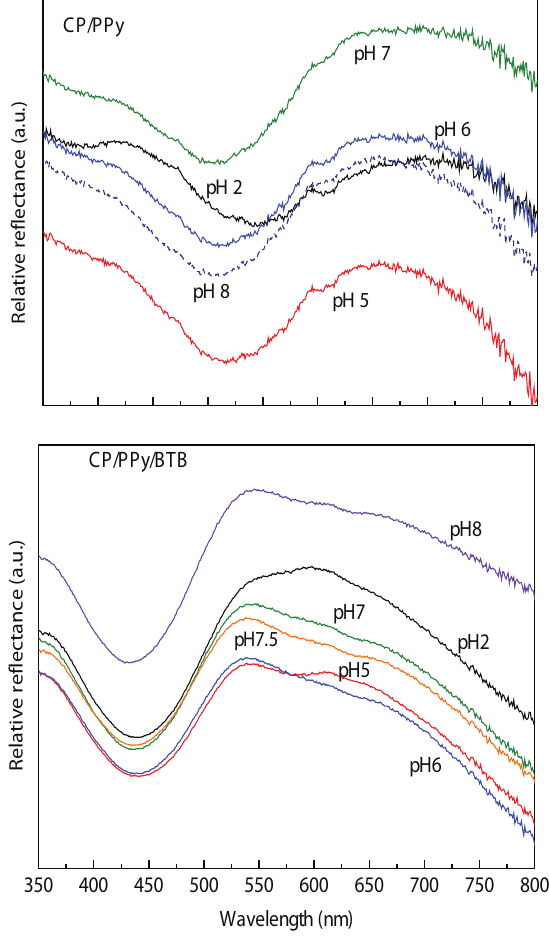
Figure 7: DRS curves for PPy and CP/PPy/BTB at different pHs.